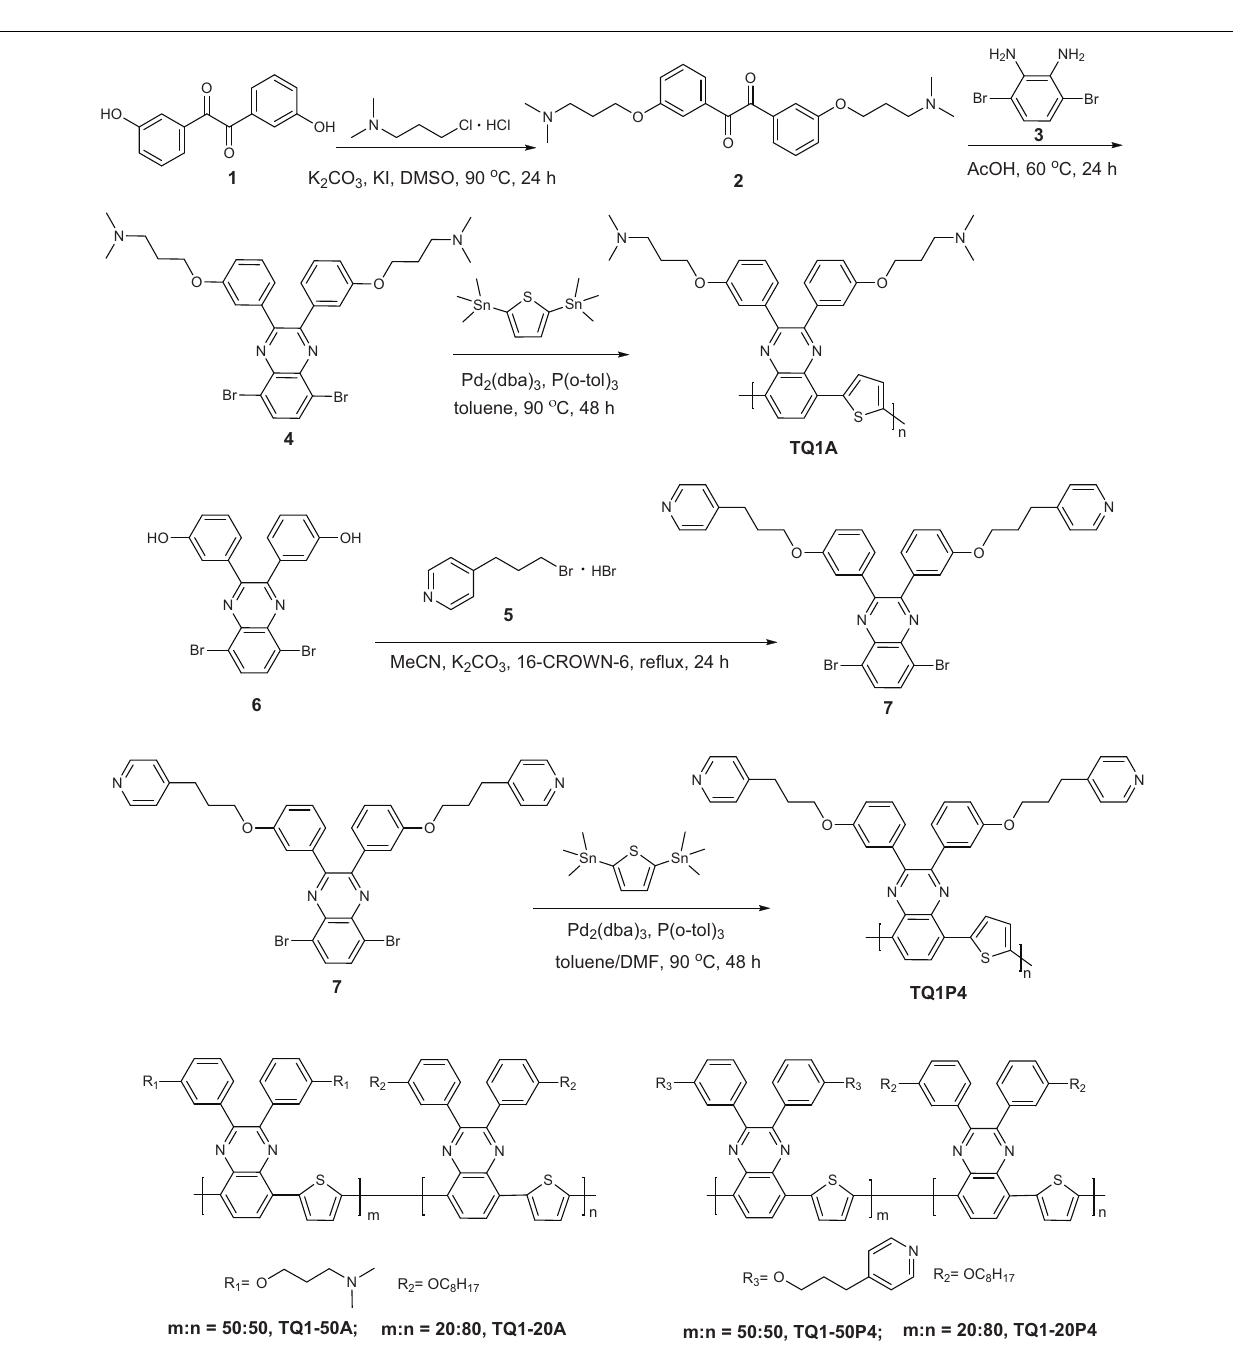
of functional groups attached to the polymer backbone. The ratio between the functional polar groups and octyl groups in the polymers was confirmed by their 1 H-NMR spectra (see Supplementary Figure S2 and Supplementary Table S1